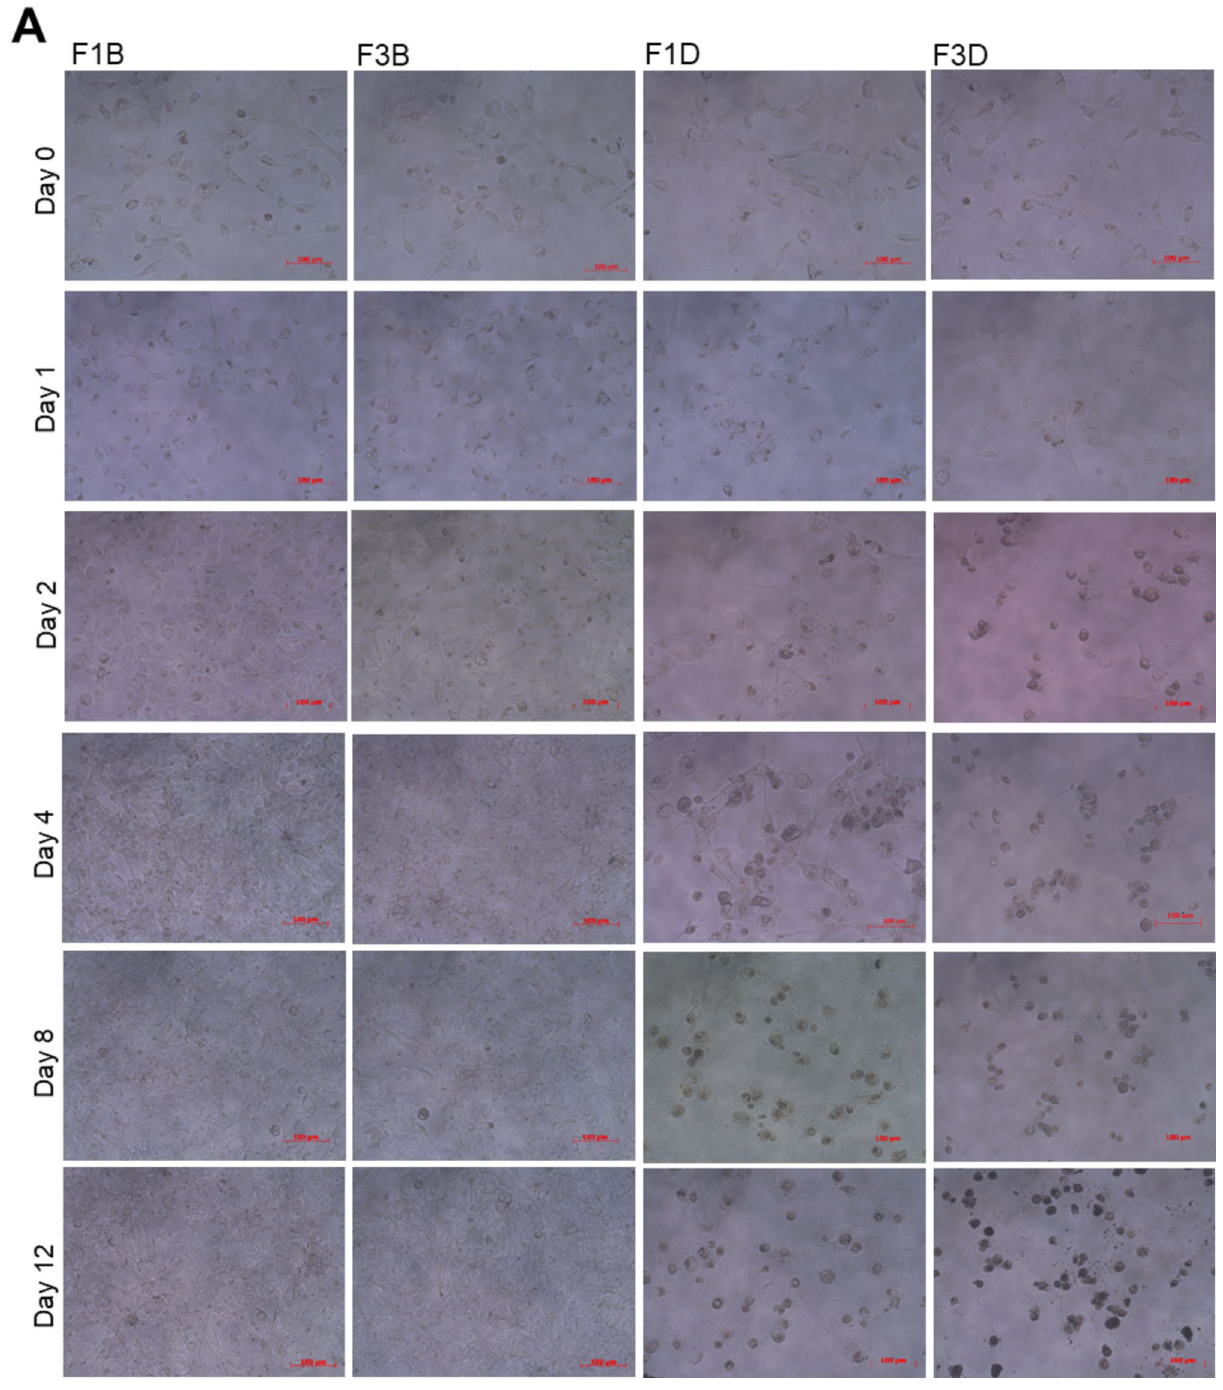
Figure 8. The morphologies of ( A ) Huh-7 cells and ( B ) Hep-3B cells before and after treatments with F1 and F3 Dox-loaded microcarriers at indicated time point. F1B and F3B: before treatment; F1D and F3D: after treatment. On day 4 after treatments with F1 or F3 Dox-loaded microcarriers, even though some cells attached on the culture dishes, most were shrunk into spheres and